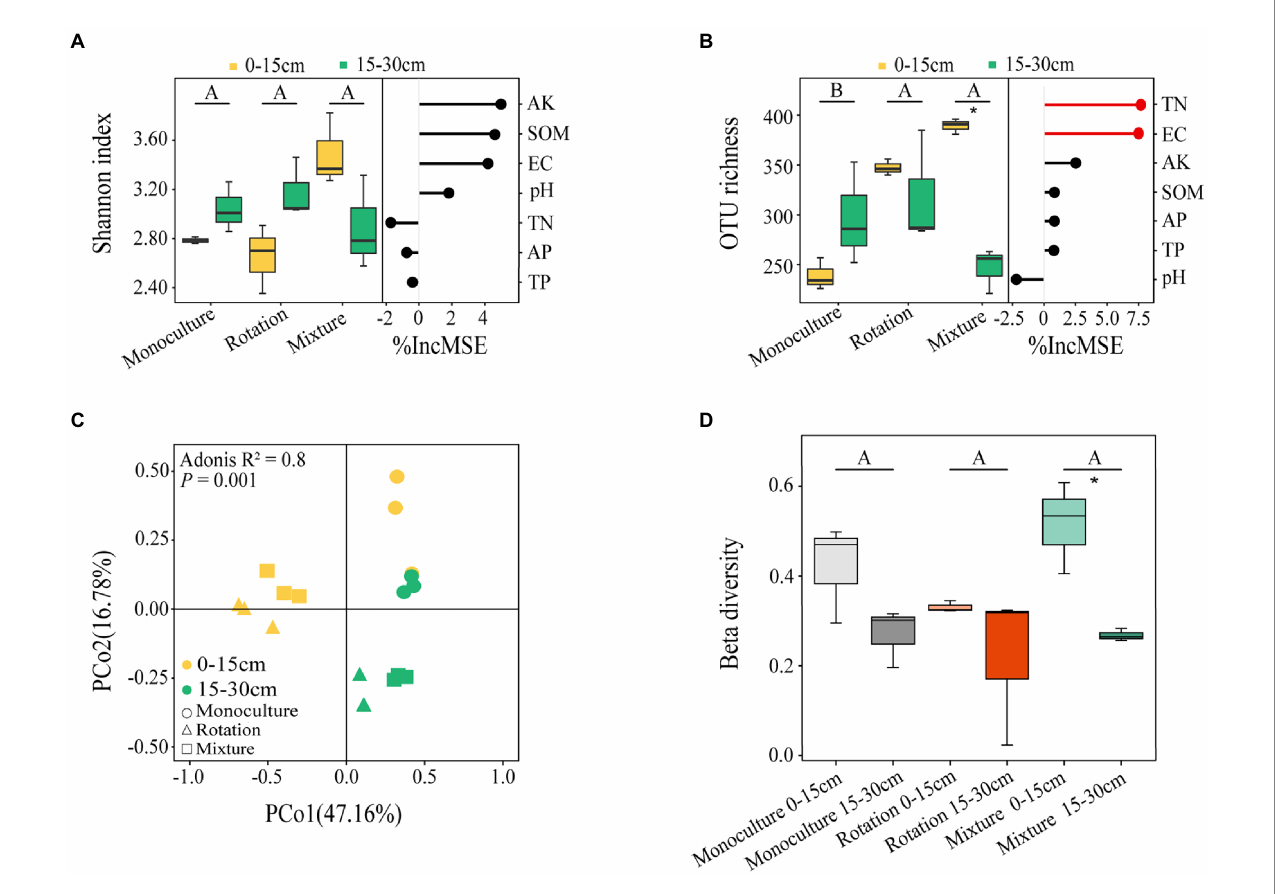
FIGURE 2 Shannon index (A) and OTU richness (B) of fungal communities at two soil depths for three cropping patterns and the importance of random forest prediction of soil variables on them. Based on Bary-Curtis distances, PCoA (C) and beta diversity index (D) of fungi community at the OTU level; Adonis tests for significant effects of different cropping patterns and soil depths on overall differences in β -diversity of microbial community structure and paired tests for differences between samples. Different letters indicate significant differences between groups ( p < 0.05). A significant difference between soil depths and statistical significance is indicated as follows. * p ≤ 0.05.